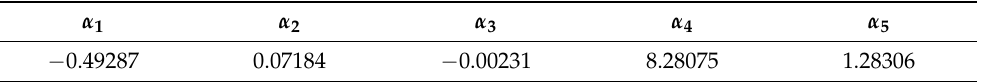
Table 6. Coefficients of the prediction model for the principal curvature of the formed surface